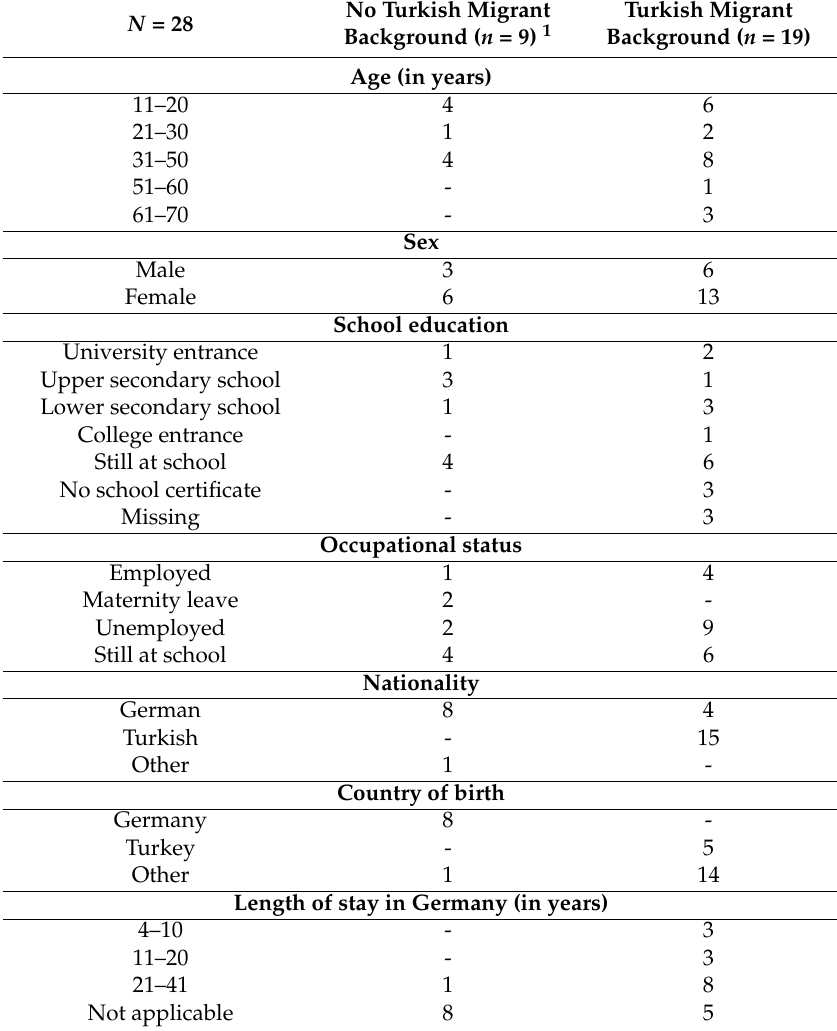
Demographic characteristics of persons who participated in the evaluation of the acceptability and usability of the health assistant (first phase of the